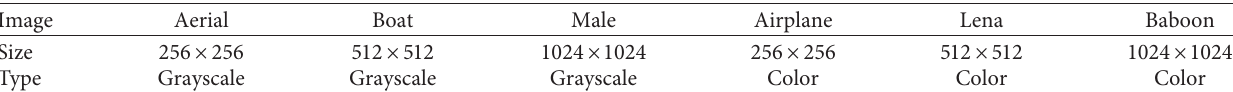
Figure 7: Encryption and decryption results: ((a)–(f)) plain images of “Aerial,” “Boat,” “Male,” “Airplane,” “Lena,” and “Baboon”; ((g)–(l)) the corresponding encrypted images; and ((m)–(r)) decrypted images. Table 1: Selected test images.